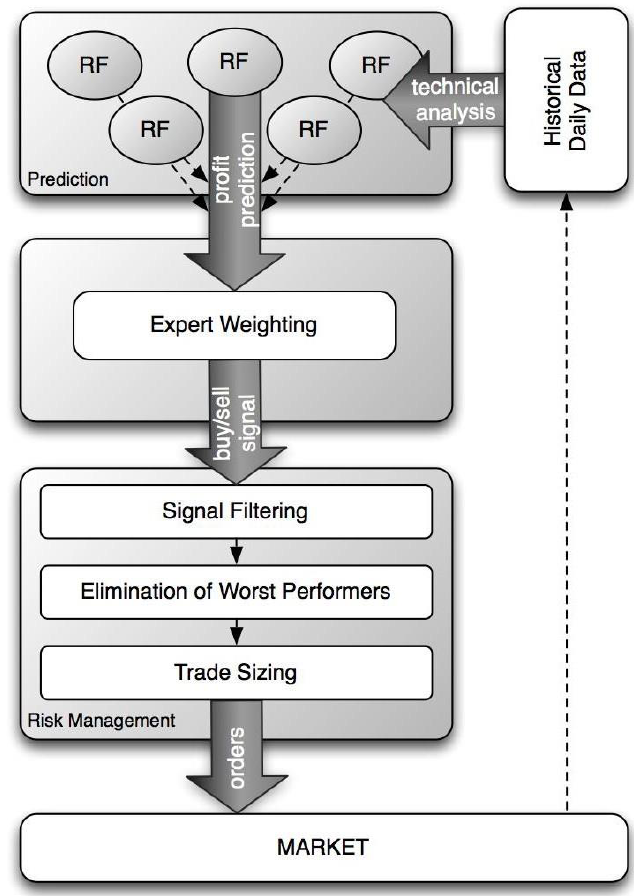
Figure 1 : Diagrammatic representation of the layered workings a fully automated expert trading system